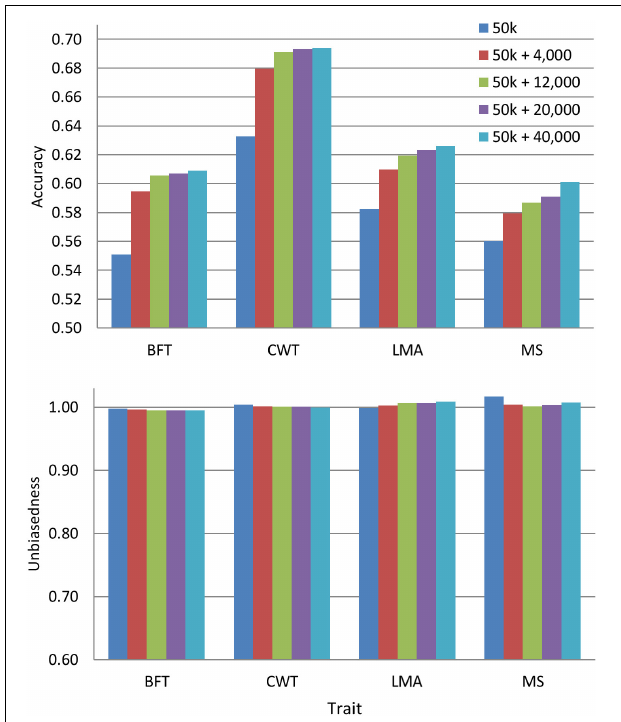
FIGURE 3 | Accuracy and unbiasedness of genomic predictions using the regular 50 k SNP panel and 50 k with the combined pre-selected variants from whole-genome sequence (1,000, 3,000, 5,000, or 10,000 variants from each trait). These variants were pre-selected from entire whole-genome sequence data. These traits were backfat thickness (BFT), carcass weight (CWT), longissimus muscle area (LMA), and marbling score (MS).